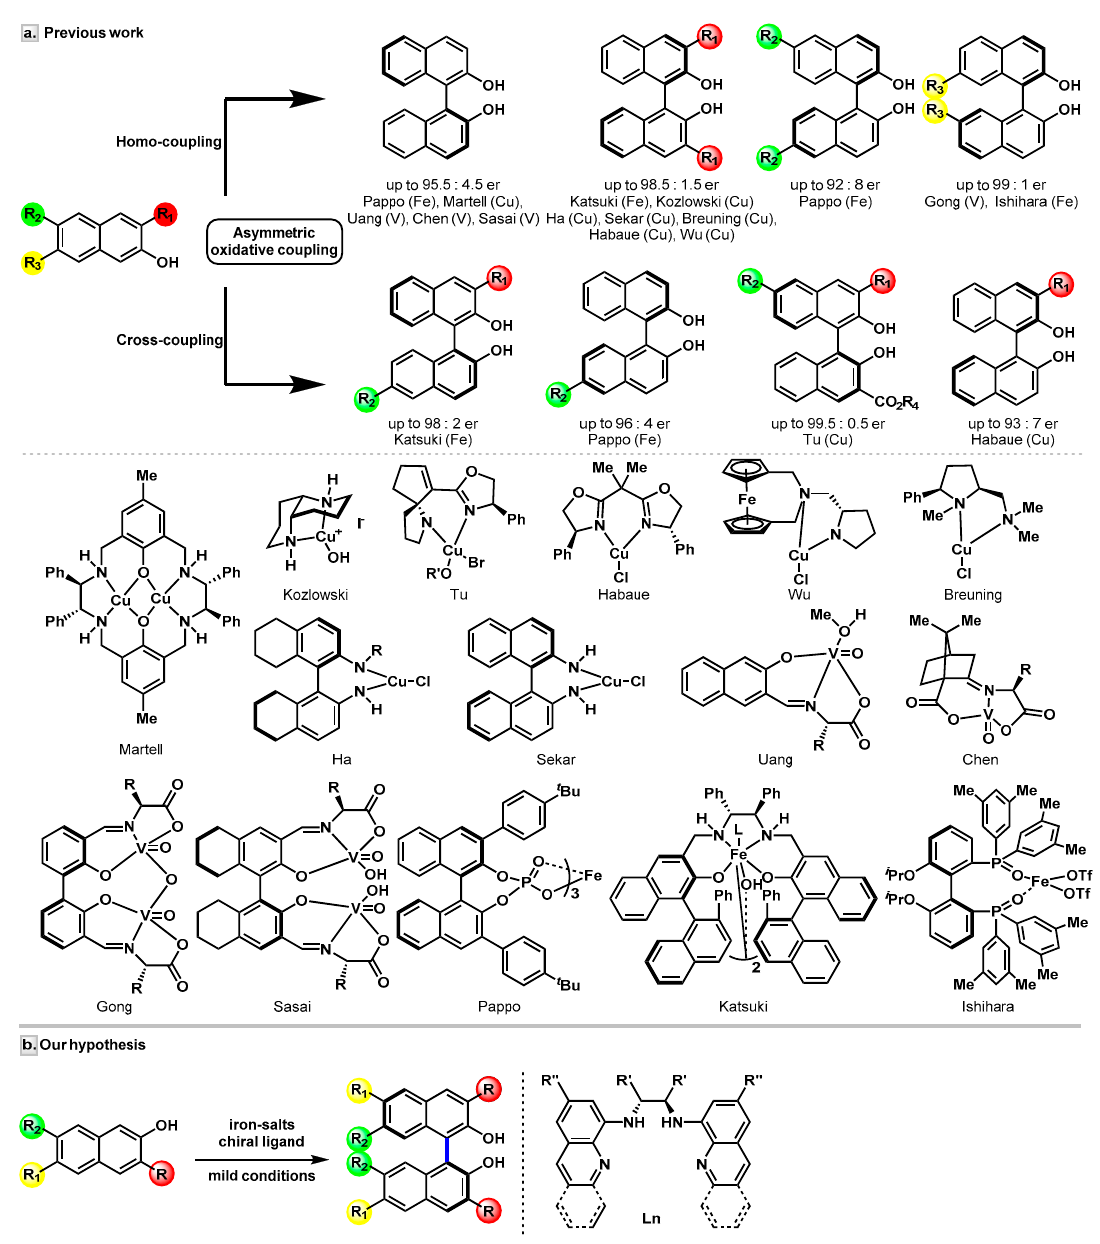
Figure 2. Transition metal-catalyzed coupling for the enantioselective synthesis of BINOLs. ( a ) The previous examples of homo- or cross-coupling of 2-naphthols. ( b ) Our proposed asymmetric oxidative homo-coupling of 2-naphthols using iron / bisquinolyldiamine